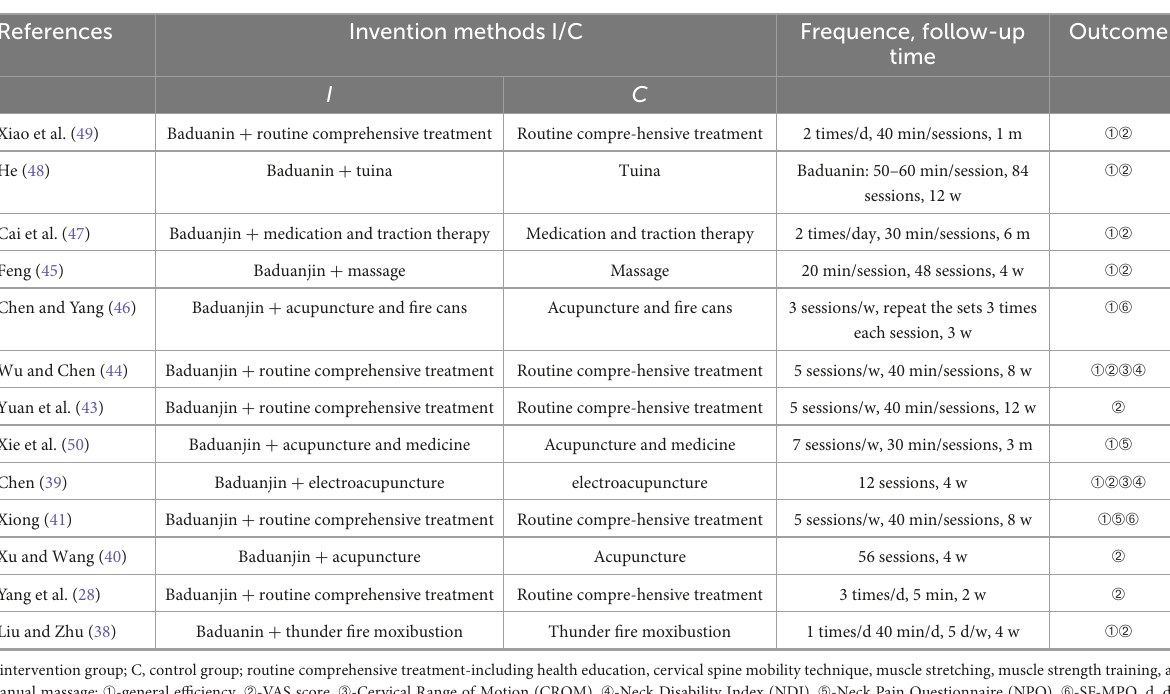
TABLE 2 Baseline features of the included studies (2).